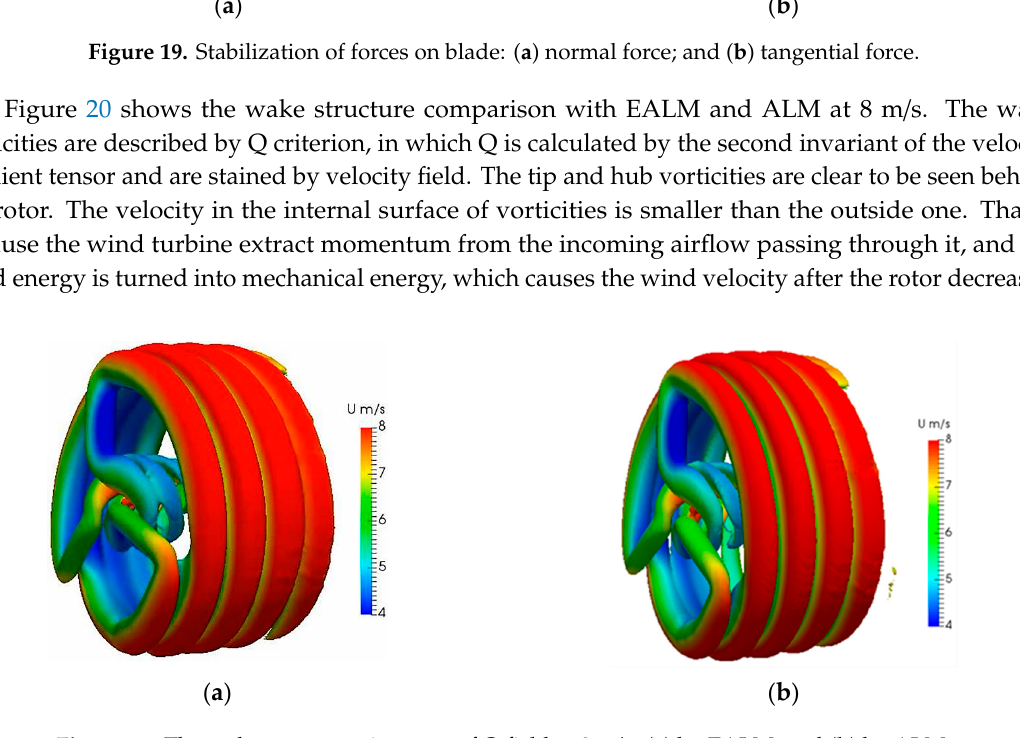
discovered in 1 direction from left side view. Besides, it focuses on blade tip in 0 direction from front